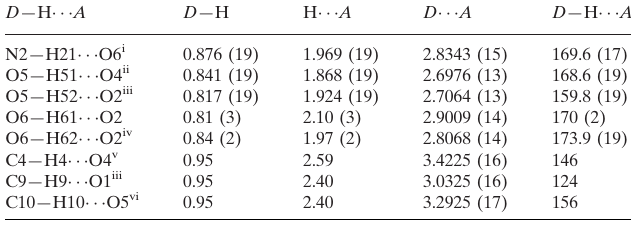
Hydrogen-bond geometry (A˚ , (cid:3) ). D —H (cid:2)(cid:2)(cid:2)